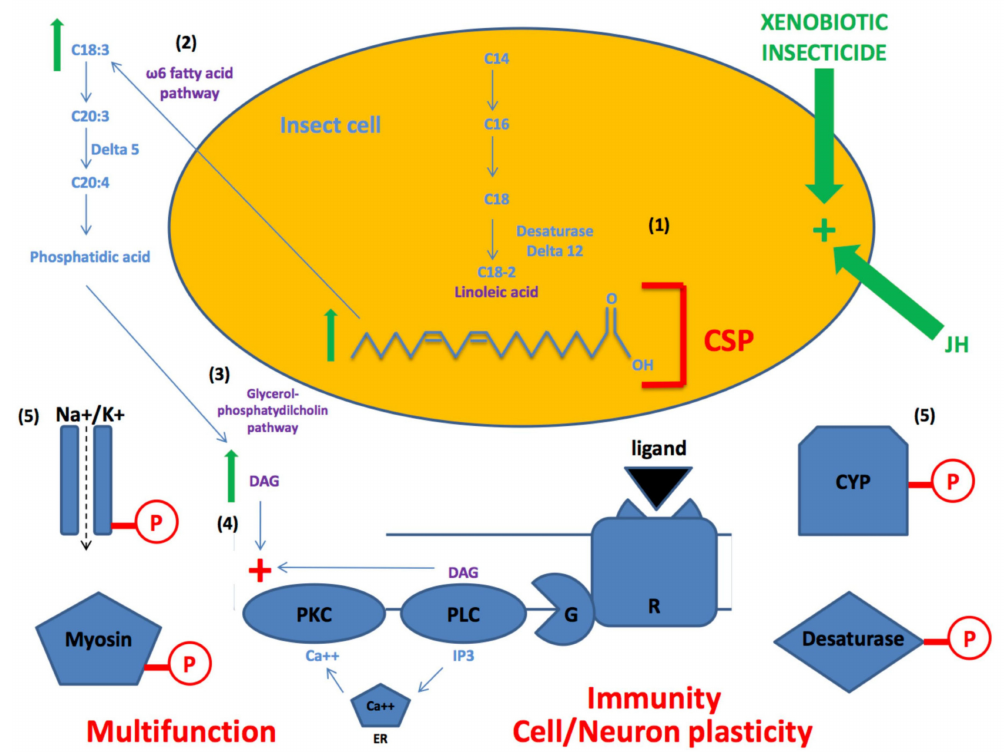
Figure 6. Conjectural model of the role of CSP in activation of linoleic acid / omega6 fatty acid-diacylglycerol pathway upon xenobiotic insecticide or juvenile hormone exposure. ( 1 ) Some insect cells have the ability to synthesize linoleic acid (C18:2) de novo using fourteen-eighteen carbons-fatty acids (C14–C18) and specific desaturases. ( 2 ) C18:2 is fuel molecule for omega6 fatty acid pathways. Molecules such as arachidonyl-CoA ((Z5,Z8,Z11,Z14)-Icosatetraenoyl-CoA or C20:4) are products of a ∆ 5 desaturase reaction from eicosatrienoyl-CoA (C20:3) as a direct substrate. ( 3 ) Synthesis of these fatty acid metabolites leads to phosphatidic acid and therefore to the formation of diacylglycerol (DAG) through the biosynthetic pathway of glycerol-phosphatydilcholins. ( 4 ) DAG is a relay molecule in intracellular cascades activated by the binding of regulatory chemical ligand (labelled by a black triangle) to G-protein coupled receptor. This triggers the formation of inositol 1,4,5-triphosphate (IP3) and DAG by PLC (phospholipase C). In turn, IP3 releases the calcium ions (Ca ++ ) from intracellular stocks in the endoplasmic reticulum (ER). ( 5 ) DAG (with Ca ++ ) activates ( + ) protein kinase C (PKC), which in turn induces specific cellular responses by phosporylating a particular set of cellular proteins (ion channels, myosin, cytochrome P450, desaturase enzymes, etc.). Applying xenobiotic insecticide and / or juvenile hormone (JH) activates ( + ) the DAG pathway and thereby protein phosphorylation (red symbol P) via increased concentrations of C18 and C20 fatty acids on cell growth performance and / or immune response of various tissues, organs and organ systems. The green arrow means that the concentration of C18:2, C18:3 and DAG increases with increasing concentration of xenobiotic insecticides and / or JH. The central role for CSP in ∆ 12-fatty acid pathway associated with transport of C18:2 for multifunction, immunity, cell development, tissue growth and neuronal plasticity is shown in